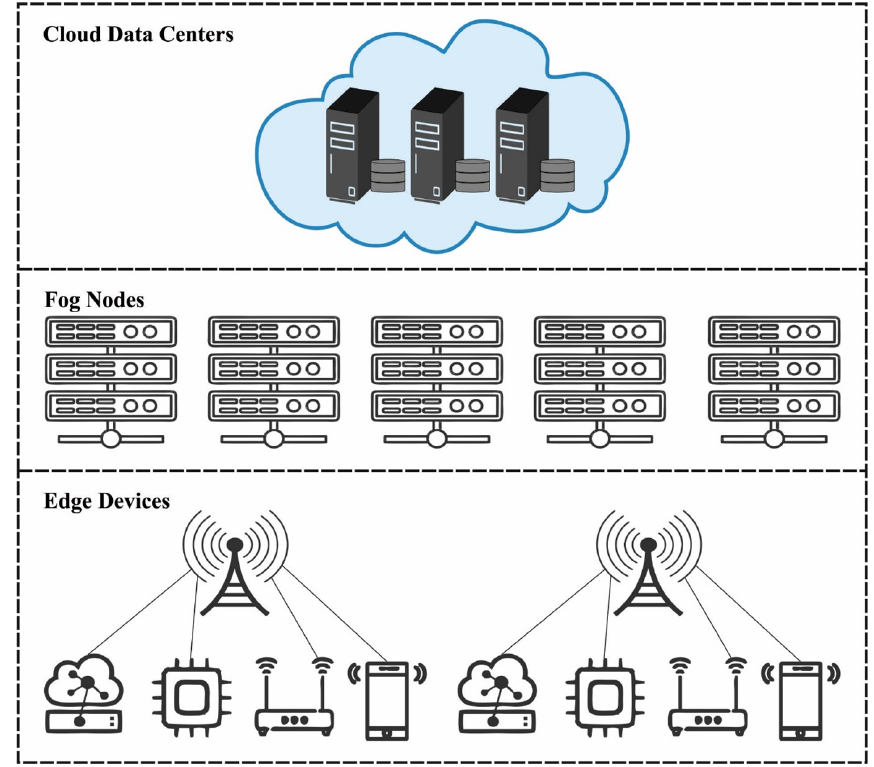
Figure 1. Fog edge